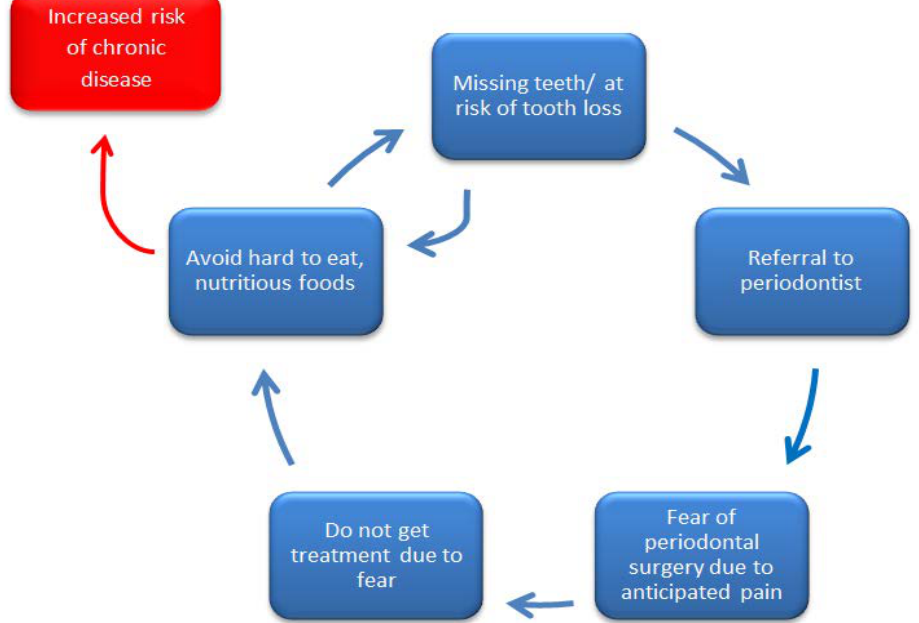
Figure 1. It is hypothesized that individuals can find themselves cycling between poor oral health (missing teeth or at risk of tooth loss) and poor nutrition (avoidance of hard to eat, nutritious foods) because they fear the necessary dental treatment that can break the cycle. Remaining in the cycle between poor oral health and poor nutrition may put an individual at an increased risk of developing chronic disease. chronic